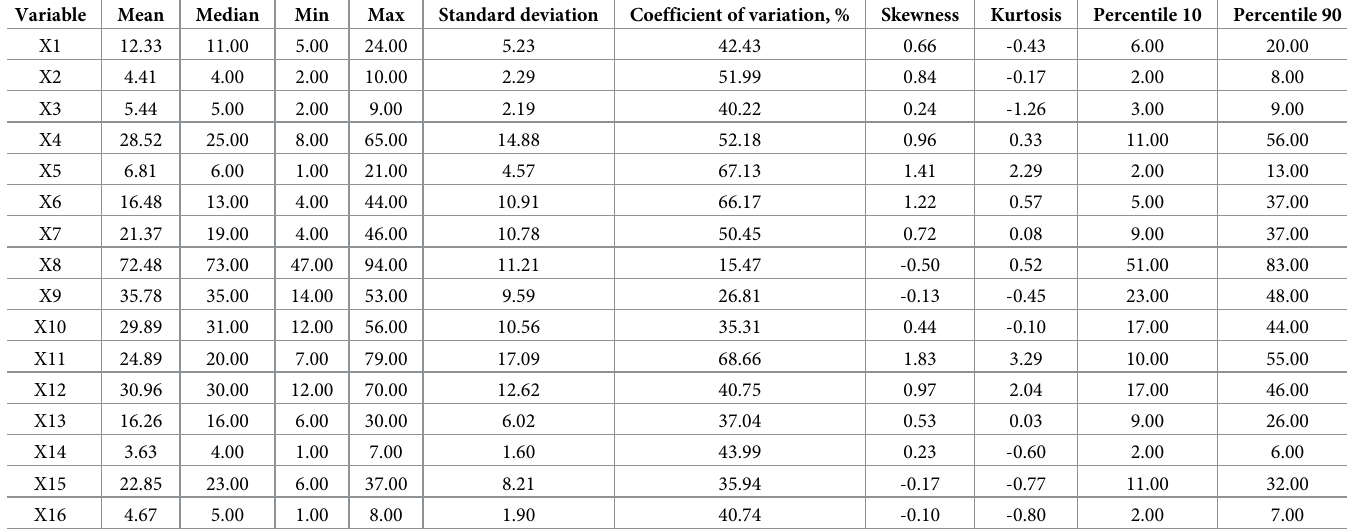
Table 2. Statistical parameters of indicators determining the level of the EU countries in terms of digitalization and robotization of all enterprises.